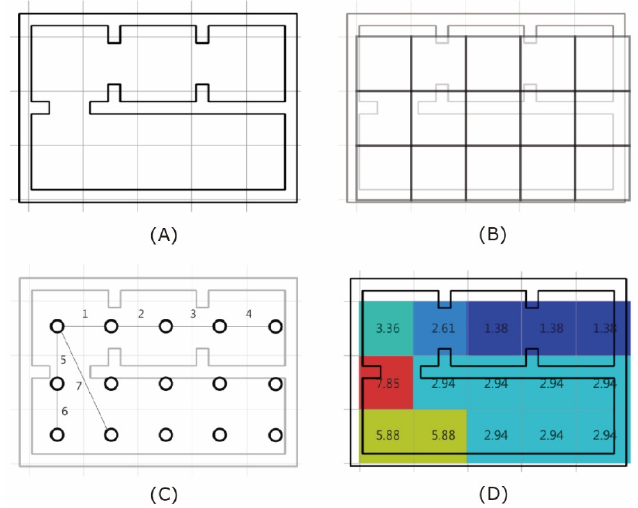
Figure 2. Spatial representation in visibility analysis: ( A ) floor plan, ( B ) grid, ( C ) visual relations, and ( D ) visibility graph.